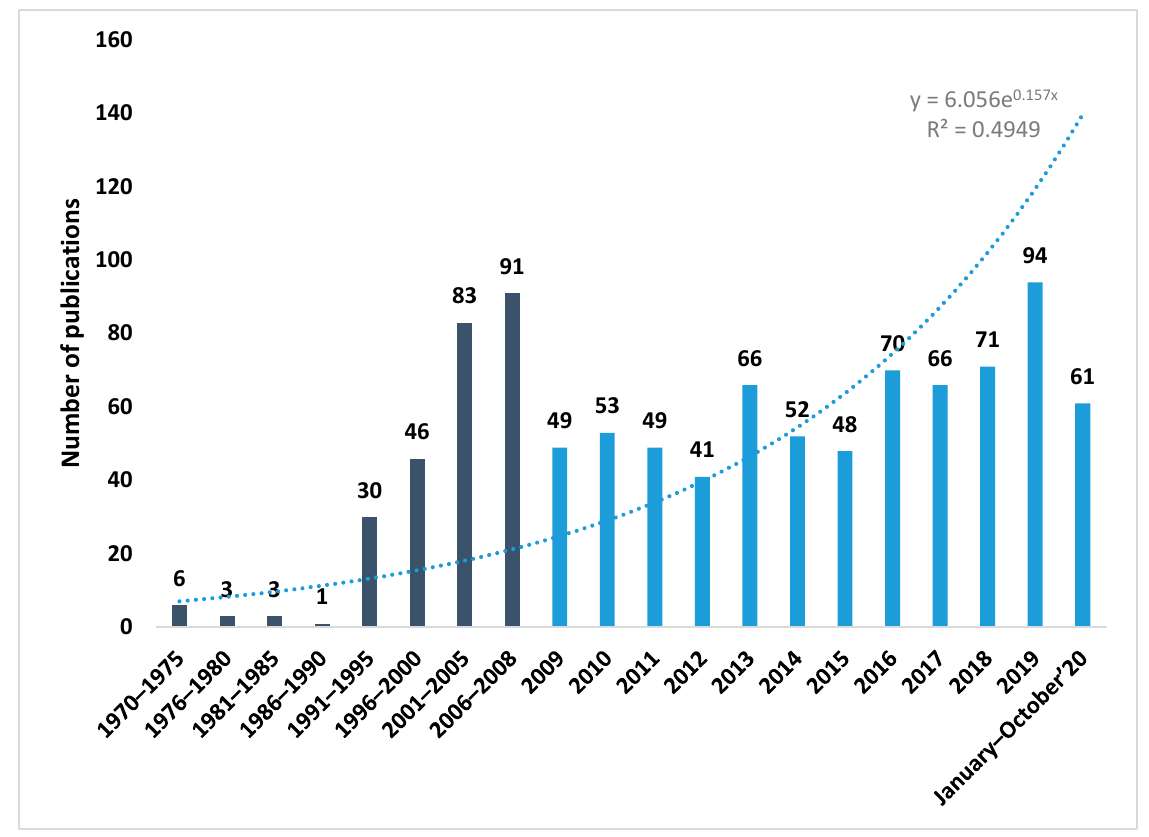
Figure 1. Number of publications per year.